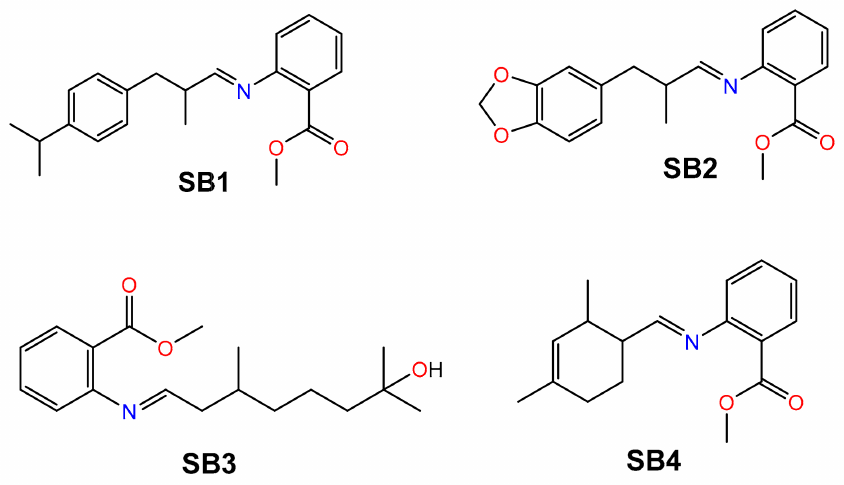
Figure 1. Structure of the four Schiff bases SB1 – SB4 discussed in this